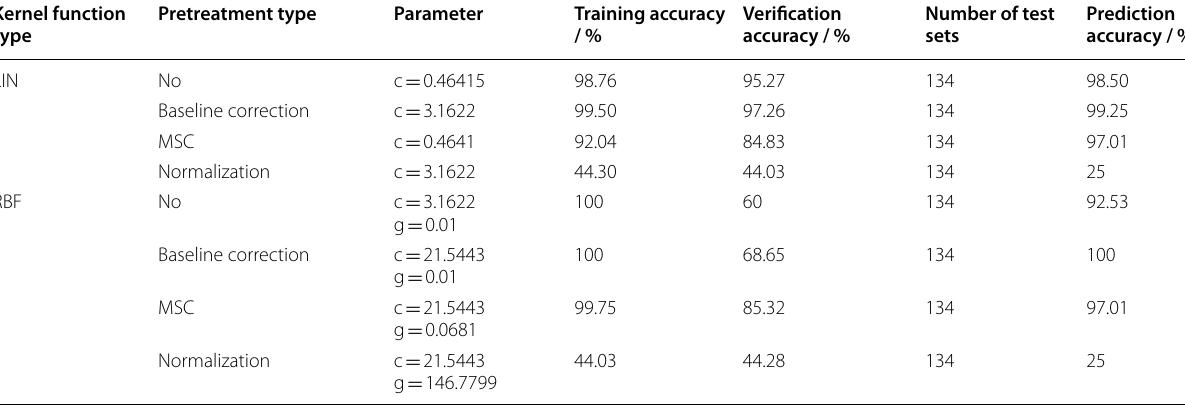
Table 2 The SVM model of results after band selection of absorption coefficient spectrum Kernel function